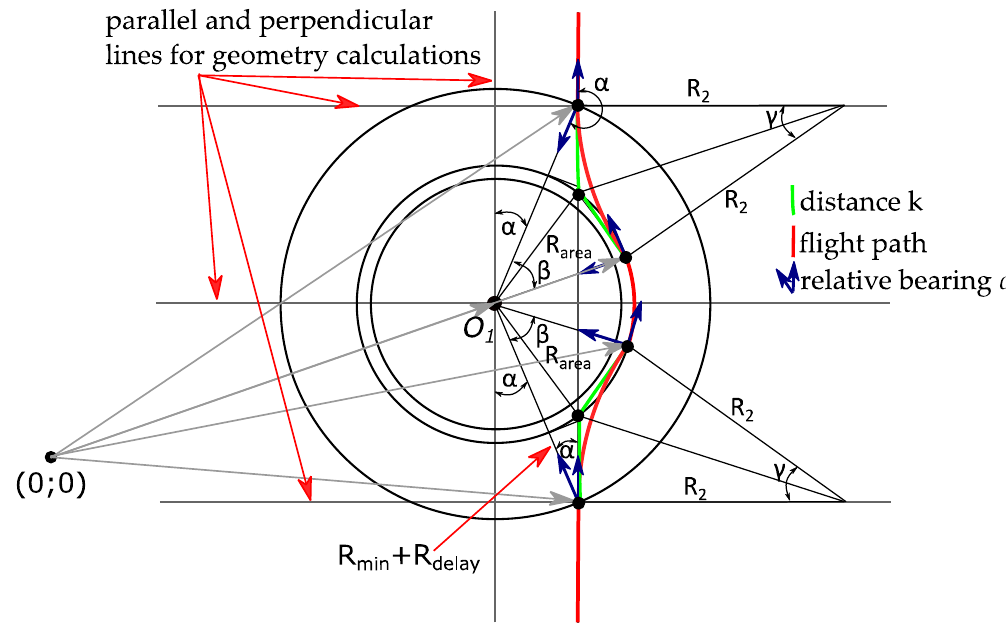
Figure 4. Geometry of ground obstacle avoidance.